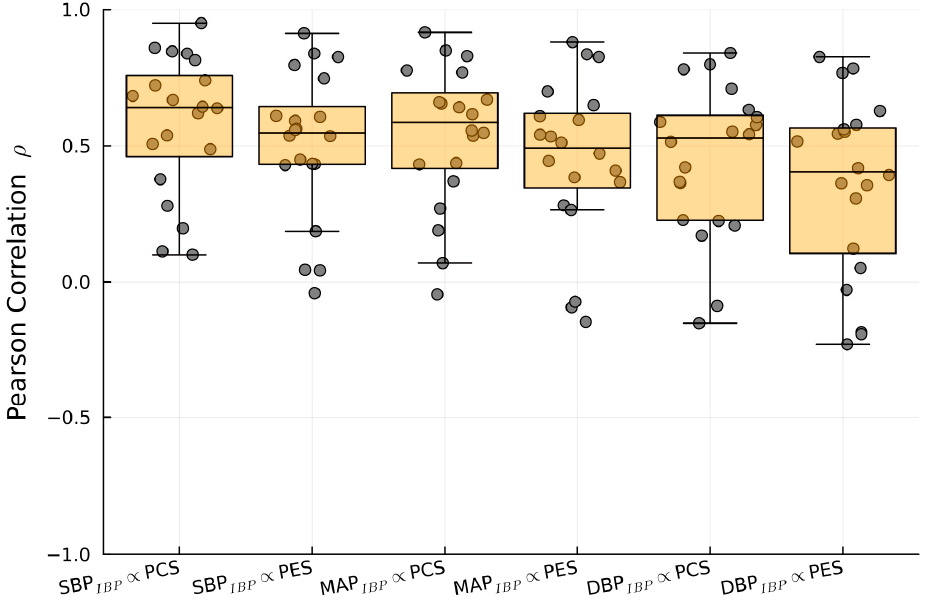
Figure 10. Boxplot of the Pearson correlation between SBP IBP , MAP IBP , and DBP IBP with 1/PTT PES and 1/PTT PCS . Table 2. Correlation between 1/PTT via PES/PCS and SBP IBP , DBP IBP , and MAP IBP . Pearson correla- tion coefficient (r) and IQR are reported.